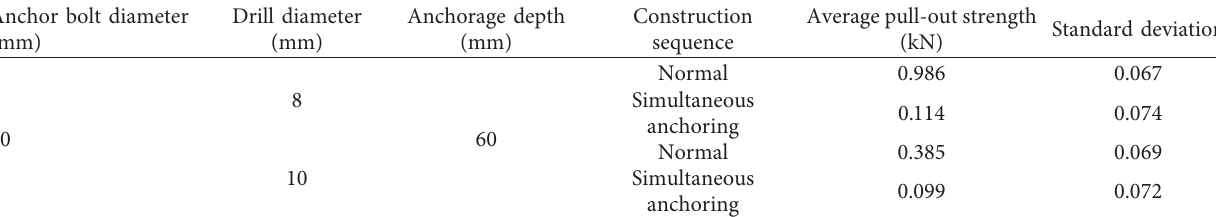
Table 2: Pull-out test strength data of different anchoring sequences.